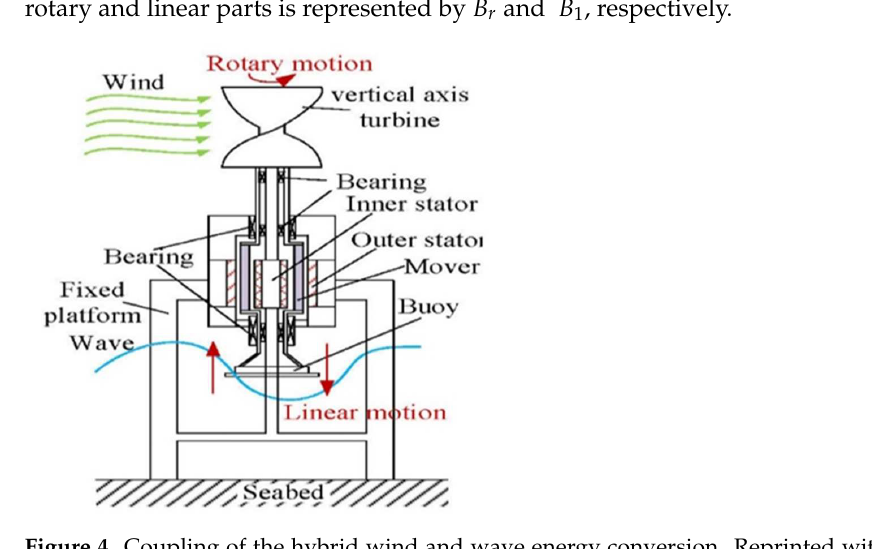
Figure 4. Coupling of the hybrid wind and wave energy conversion . Reprinted with permission from Ref. [46]. 2020, IET.